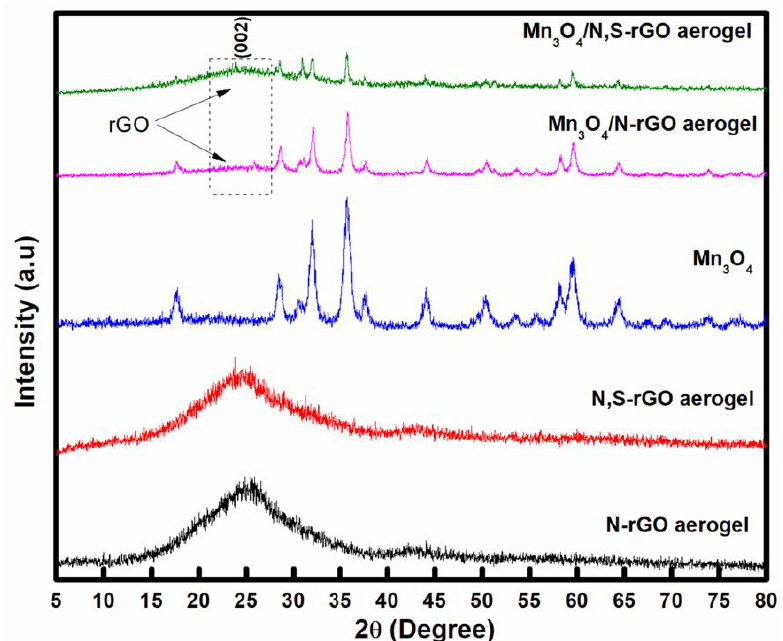
Figure 2. XRD patterns of Mn 3 O 4 , N-rGO aerogel, N,S-rGO aerogel, Mn 3 O 4 /N-rGO aerogel, and Mn 3 O 4 /N,S-rGO aerogel.